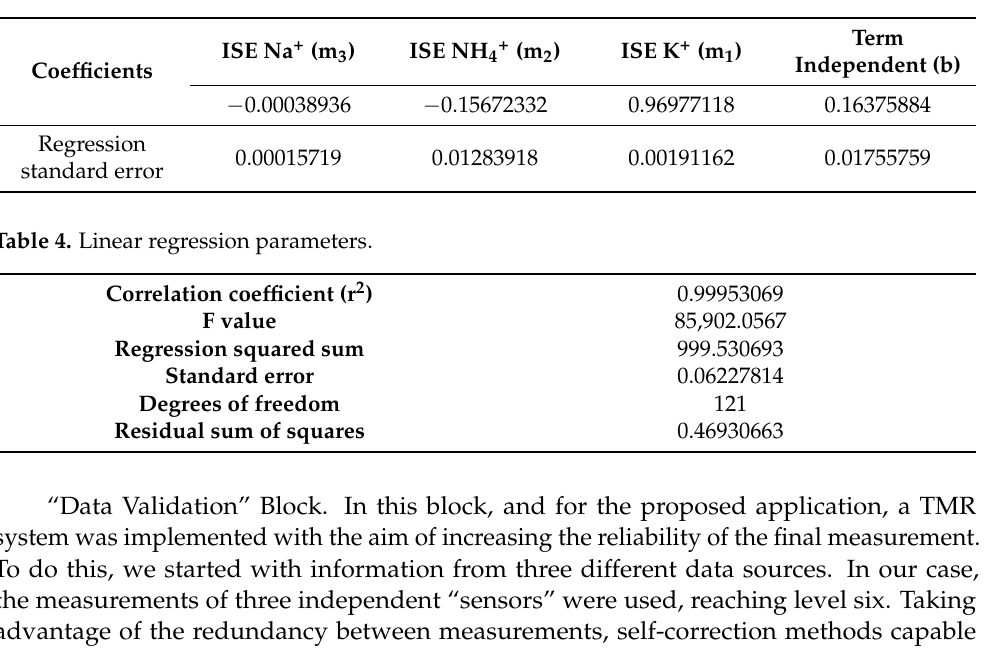
Table 3. Results of the linear regression.